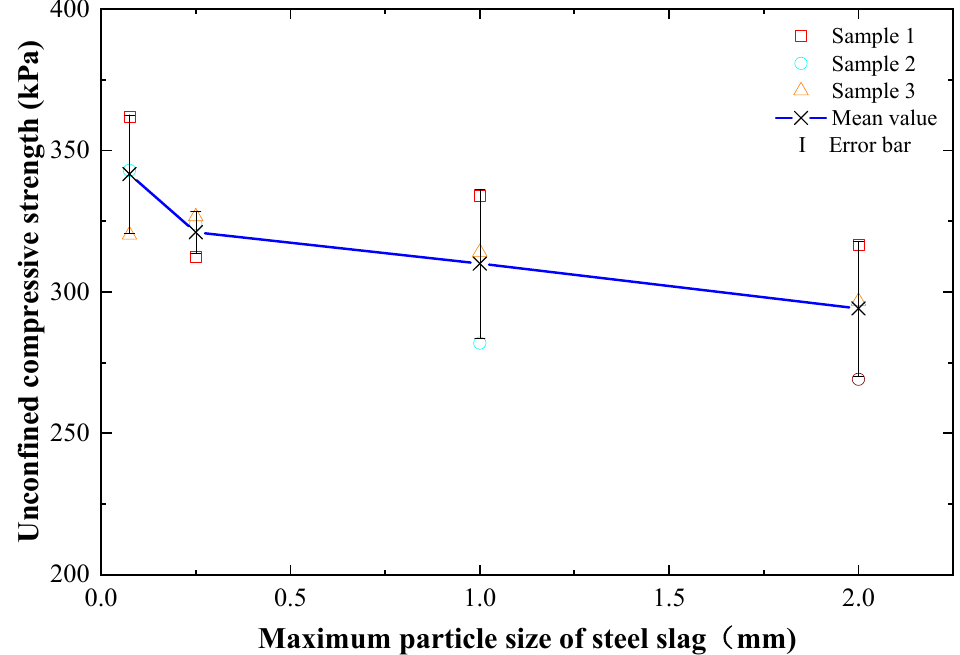
Figure 5. Compressive strength variations of cement- and steel-slag-stabilized dredged soils with different maximum particle sizes of steel slag.